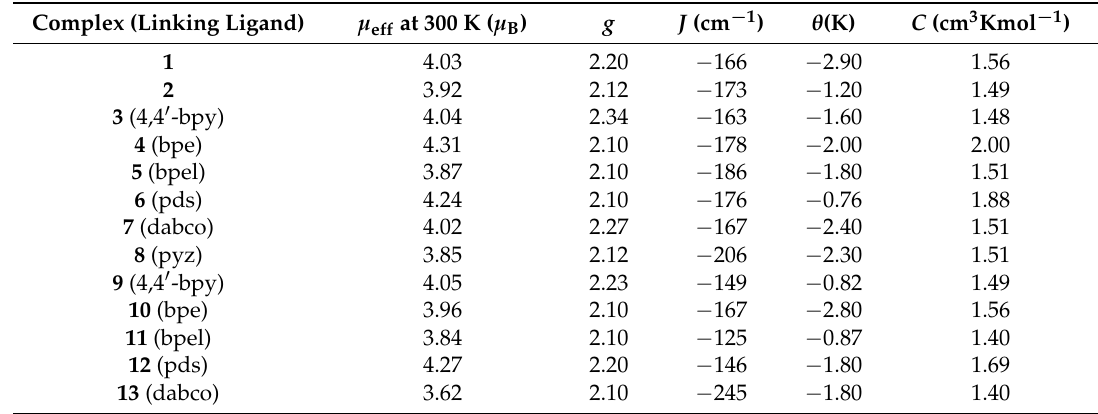
Table 7. Magnetic data of the chain